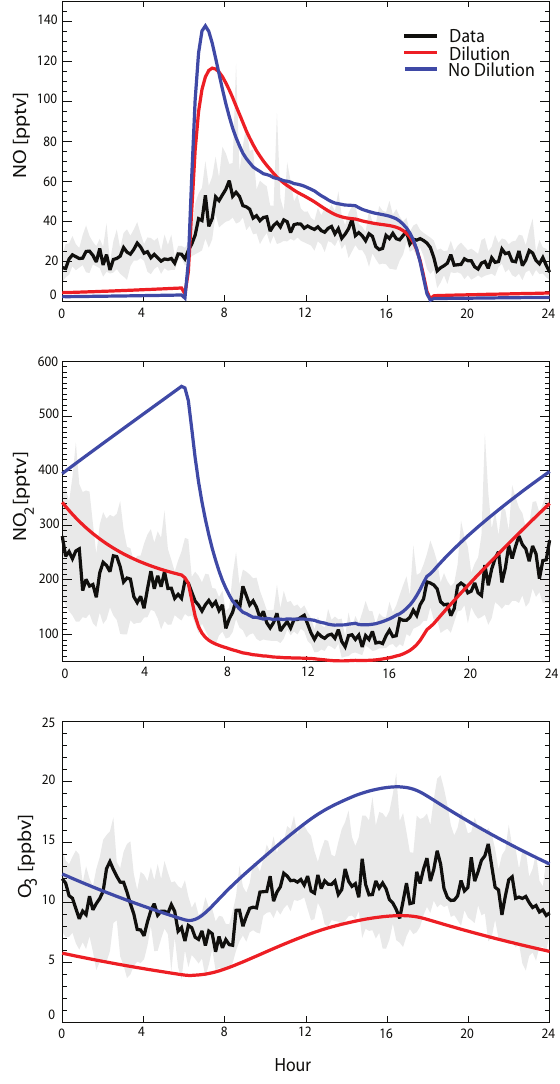
Fig. 4. Box model comparison with (red) and without (blue) venting against diurnal cycle of NO, NO 2 , and O 3 from the median diurnal cycle in the measurements (black, with 25–75 quartile in grey).